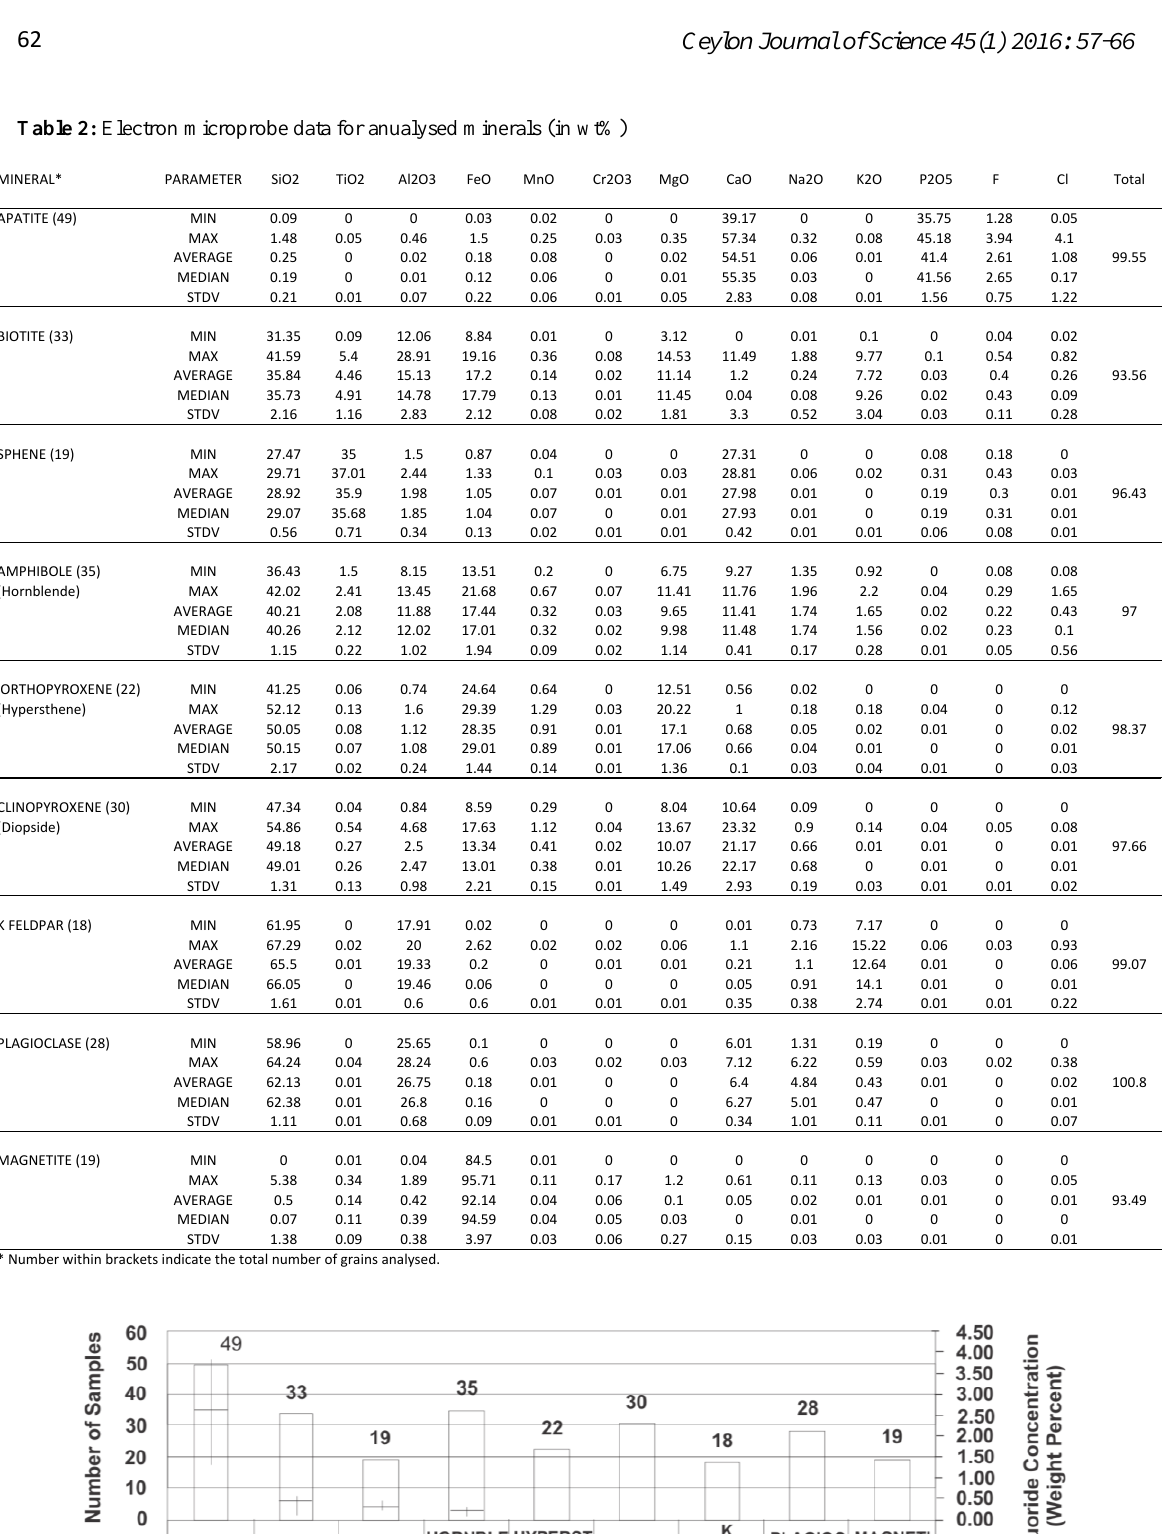
Table 2: Electron microprobe data for anualysed minerals (in wt%) Table 2. Electron microprobe data for analysed minerals (in wt % ) MINERAL*